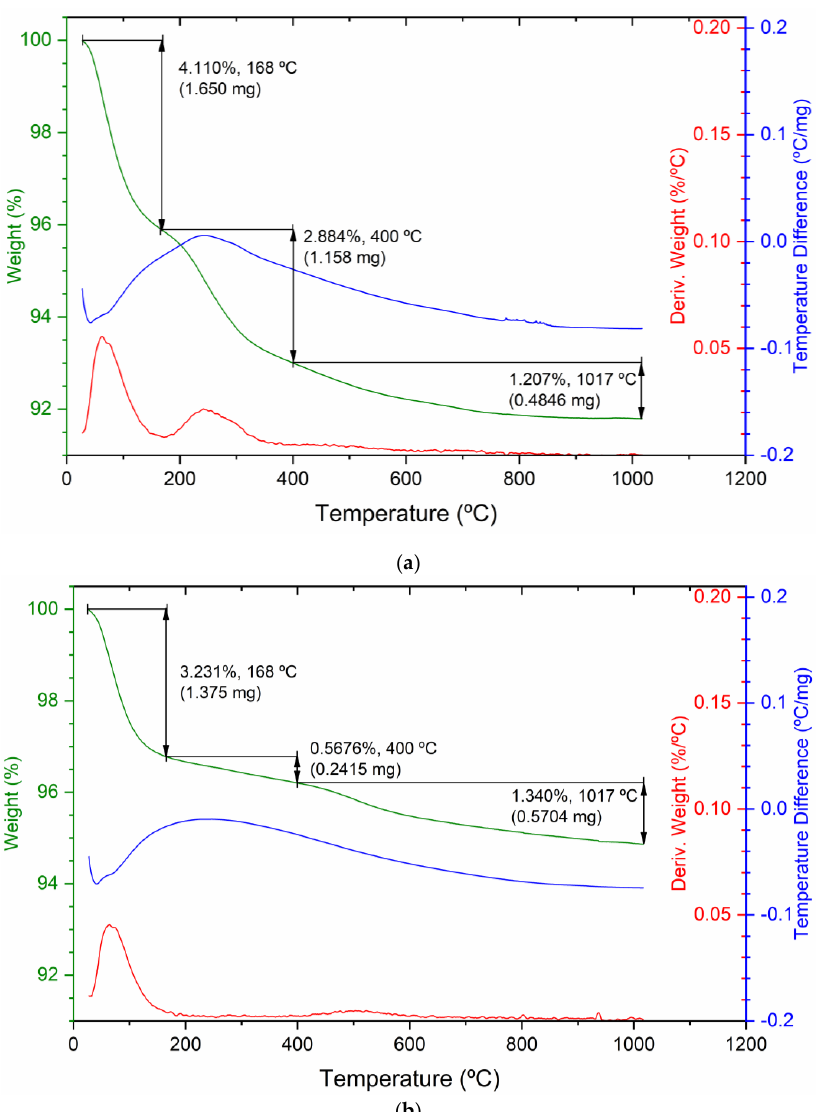
Figure 3. ( a ) TGA graphs of GSLP-Fe(0) D3 and ( b ) GSLP-Fe D3 decomposition in air (% weight, green). The derivative thermogravimetry (DTG, %/°C, red) and temperature difference (°C/mg, blue) are also shown for both graphs.